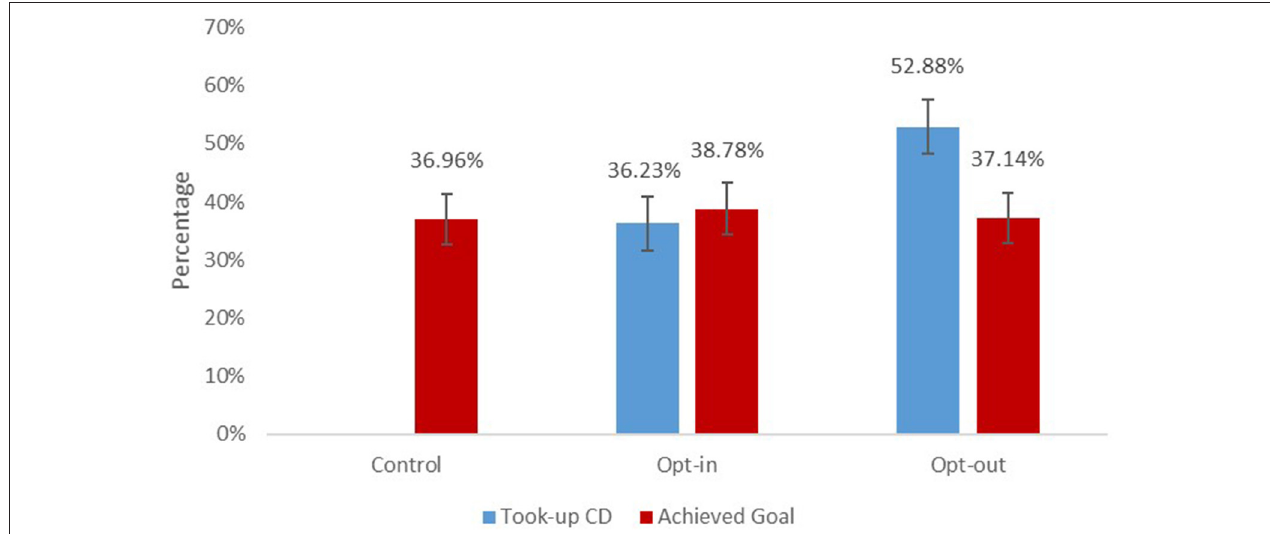
FIGURE 1 | Percentage of students who took-up commitment device and achieved their goal by treatment condition. Error bars represent 95% CI. Estimates are from a logistic regression that controlled for students’ homeroom and pre-treatment math grade. Students in the Control condition did not have the opportunity to take-up the commitment